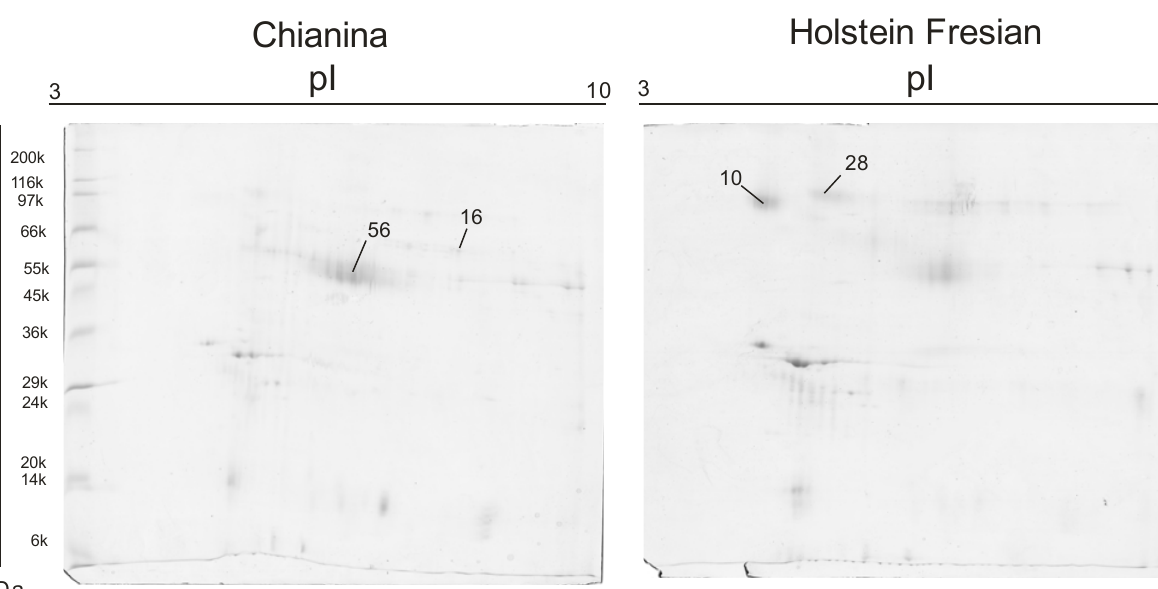
Figure 1. 2D Isolectrofocusing-Sodium dodecyl sulfate polyacrylamide gel electrophoresis of MFGM protein fractions of Chianina and Holstein cattle, respectively. Protein spots reported in Table 1 are